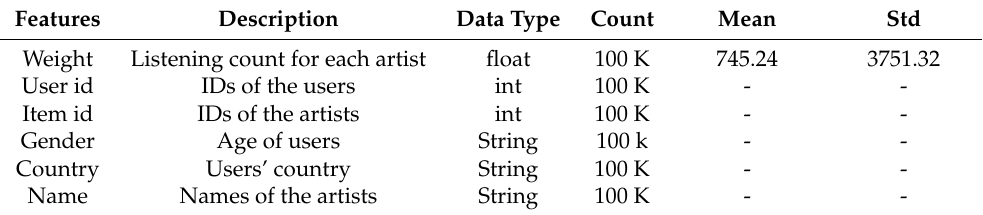
Table 2. LastFM dataset information.